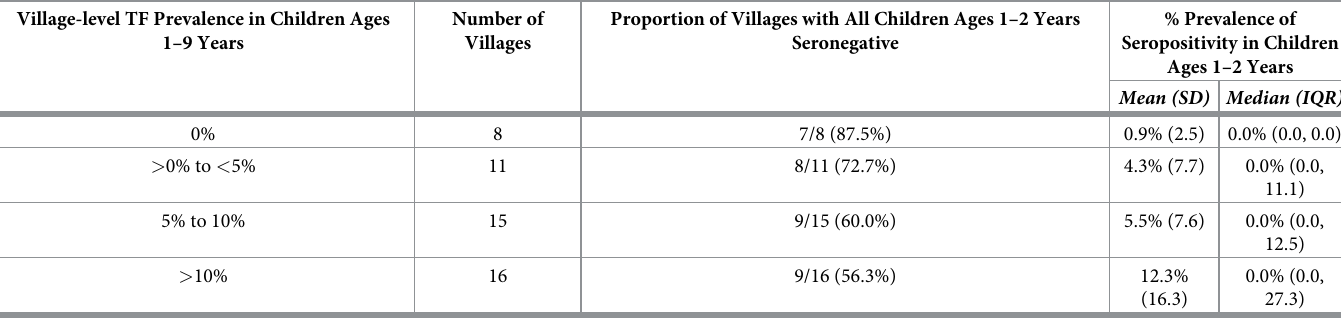
Table 4. Prevalence of seropositivity in children ages 1–2 years by village-level TF prevalence in children ages 1–9 years. Village-level TF Prevalence in Children Ages 1–9